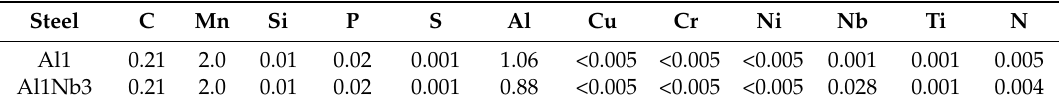
Table 1. Composition of the steels investigated in the present work (wt